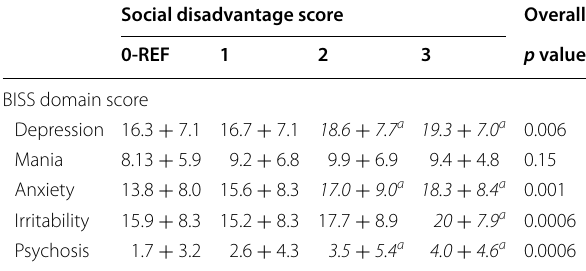
Table 2 Association between BISS symptom domains and social disadvantage